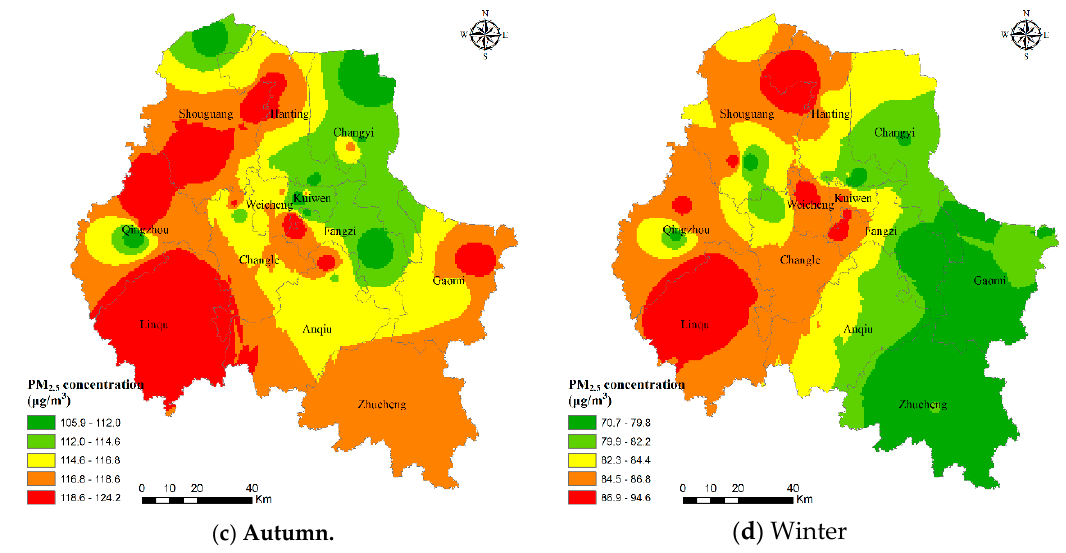
Figure 4. Spatial distribution of PM 2.5 concentrations in the four seasons in Weifang.